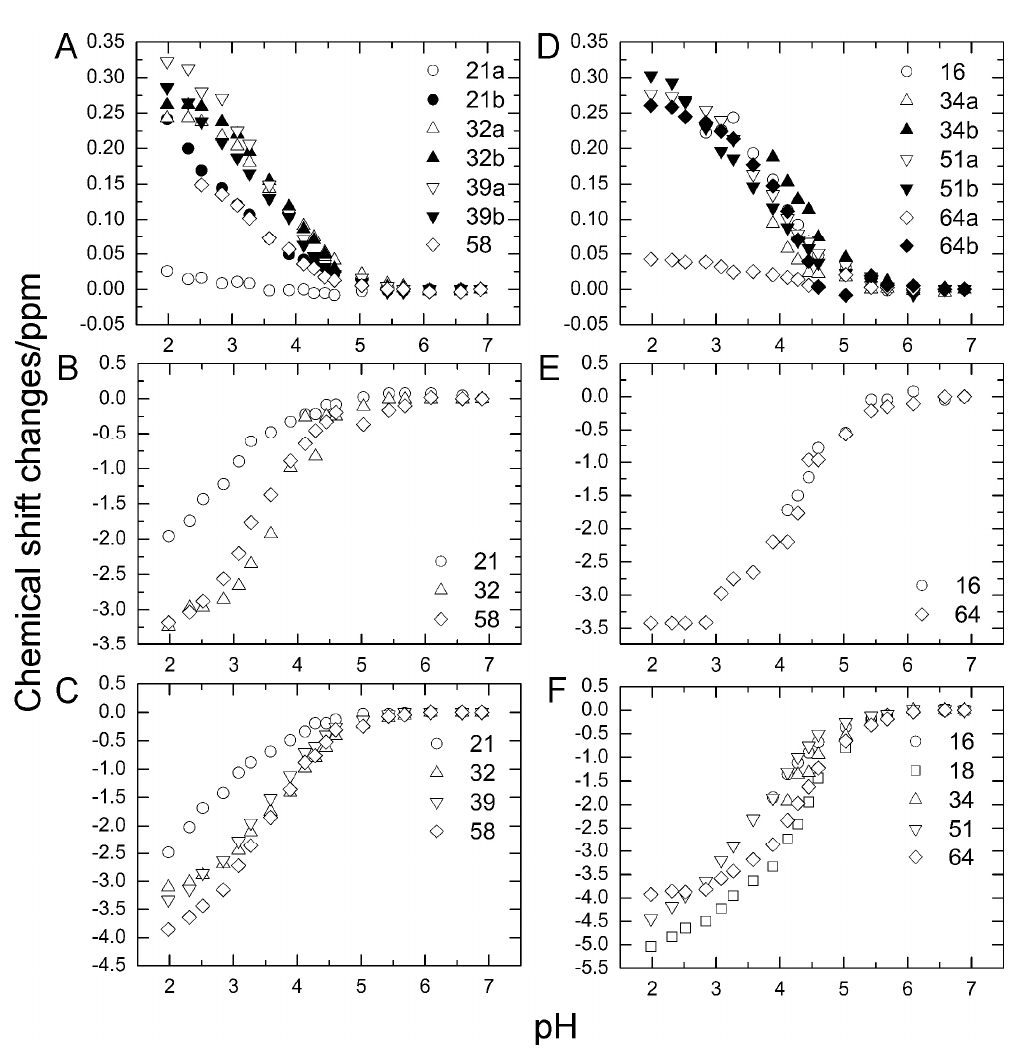
Figure 5. Changes in aspartate ( A – C ) and glutamate ( D – F ) chemical shifts of WT ubiquitin by pH titration from pH 6.88 to pH 1.98 at 298 K. ( A ) H β of aspartate; ( B ) C β of aspartate; ( C ) C ′ of aspartate, ( D ) H β of glutamate; ( E ) C γ of glutamate; ( F ) C ′ of glutamate. Table 1. Carboxyl p K a values for wild-type ubiquitin.